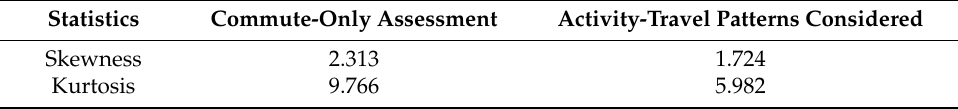
Figure 6. The histograms of traffic congestion exposure in ( a ) the commute-only assessment and ( b ) the assessment that considers participants’ activity-travel patterns. Table 4. Skewness and kurtosis of the histograms for both